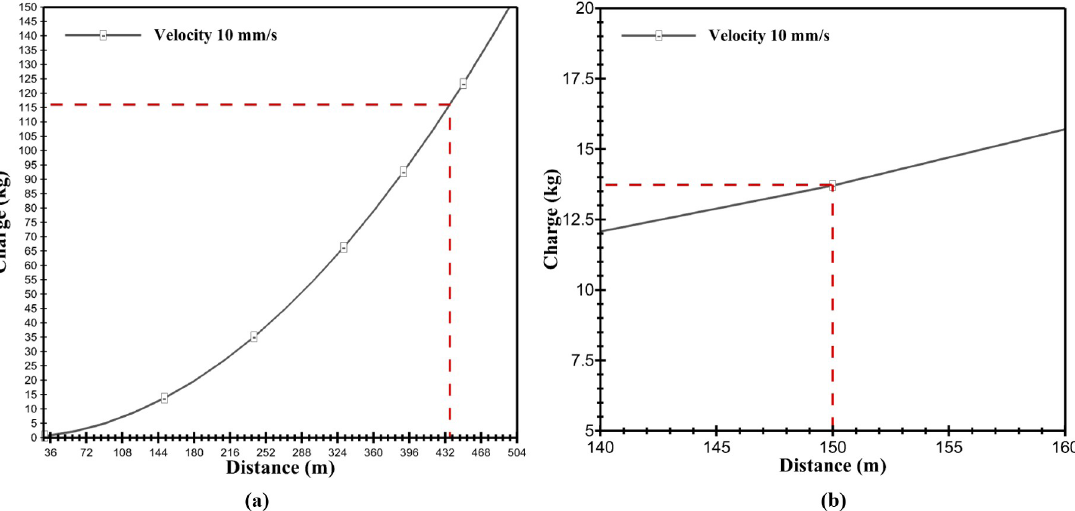
Figure 9: (a) Safe charge weight per delay (Q) for “Conveyor belt” site; (b) Safe charge weight per delay for “Panel1 (Upper exploitation level)”